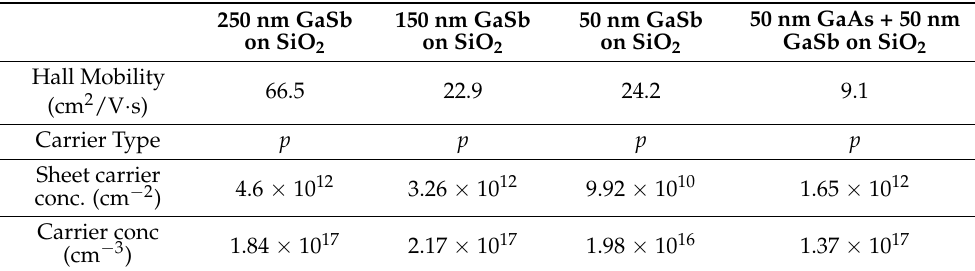
Table 1. Room temperature Hall effect measurement results for poly-GaSb films grown on SiO 2 at 475 ◦